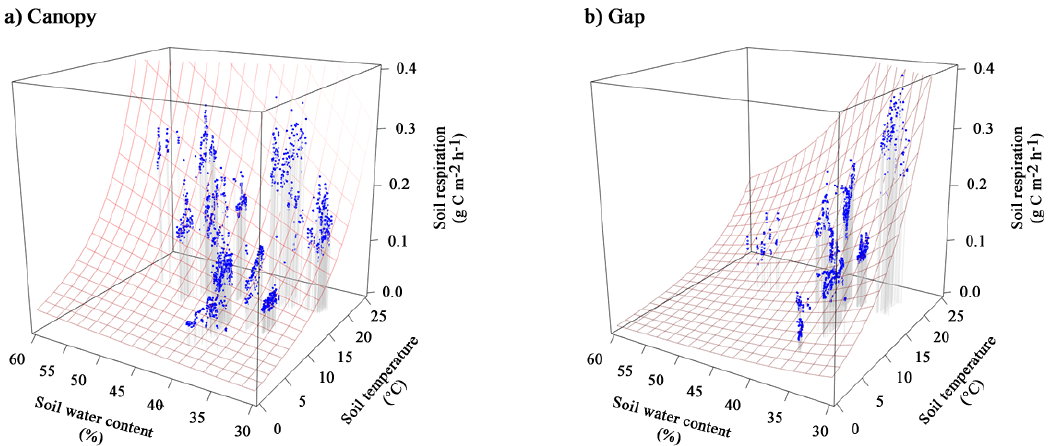
Figure 7. Relationships among soil respiration ( R s ), soil temperature ( T s ) and soil water content ( W ) in canopy ( a ) and gap ( b ) areas. The regression surface shows the best fitted model in each area. Table 1. Summary of the results of the GLMs sorted in the analysis in gap and canopy areas. Model